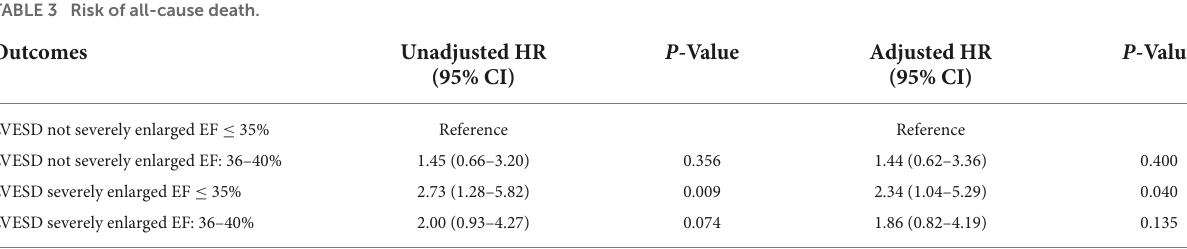
TABLE 3 Risk of all-cause